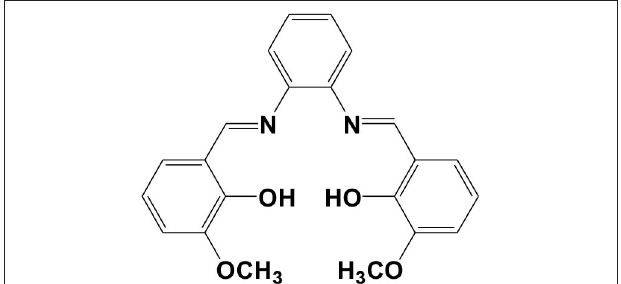
SCHEME 1 | Schiff base ligand H 2 L.